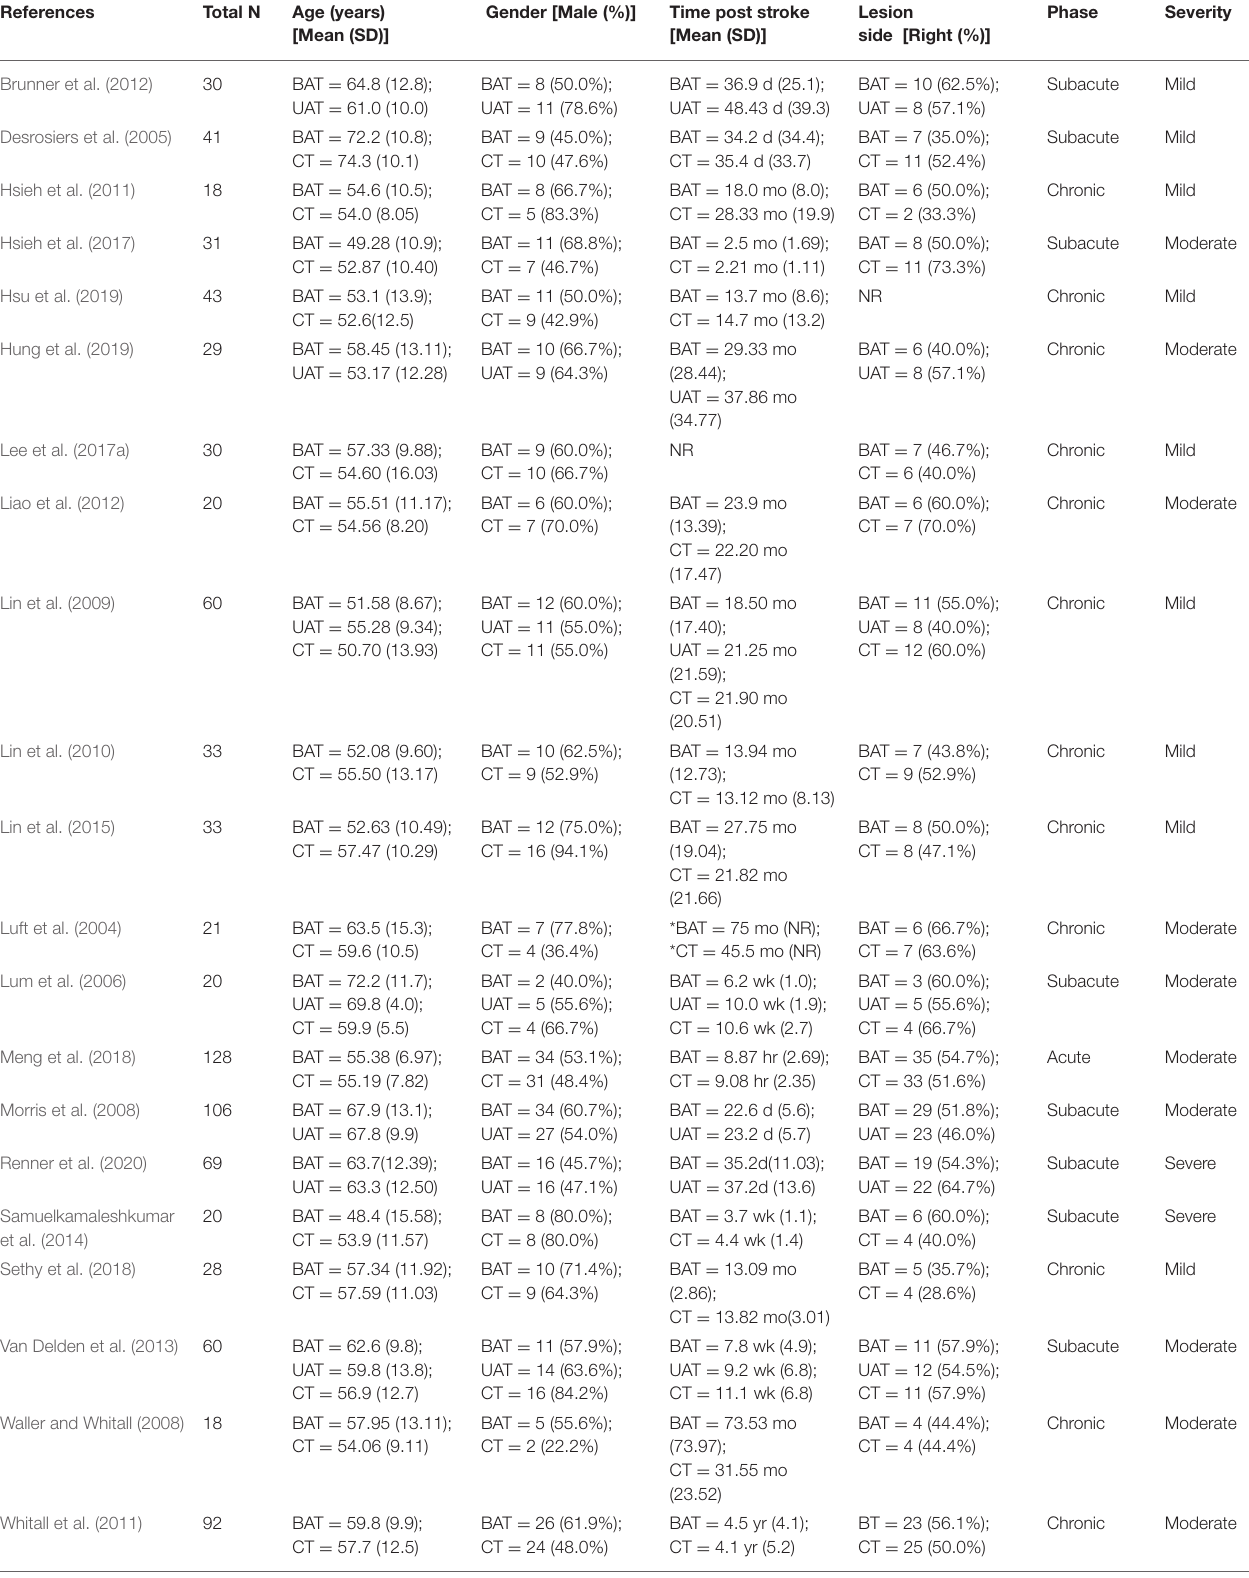
TABLE 1 | Characteristics of recruited participants included in this